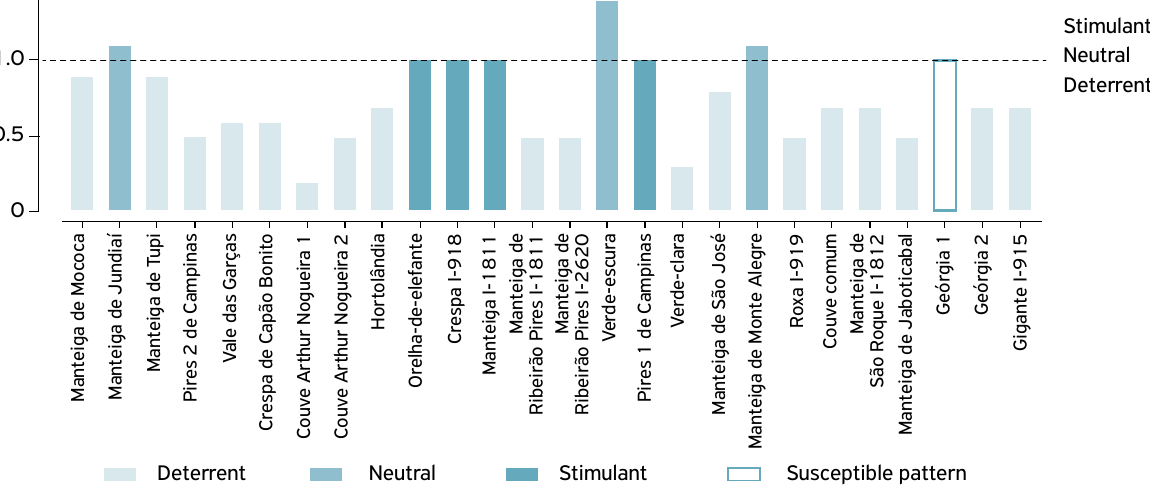
Figure 2. Attractiveness index of Ascia monuste orseis (Lepidoptera: Pieridae) in collard greens genotypes in non-choice test (temperature 25 ± 2ºC, relative humidity 70 ± 10% and photoperiod 12:12 light/darkness).